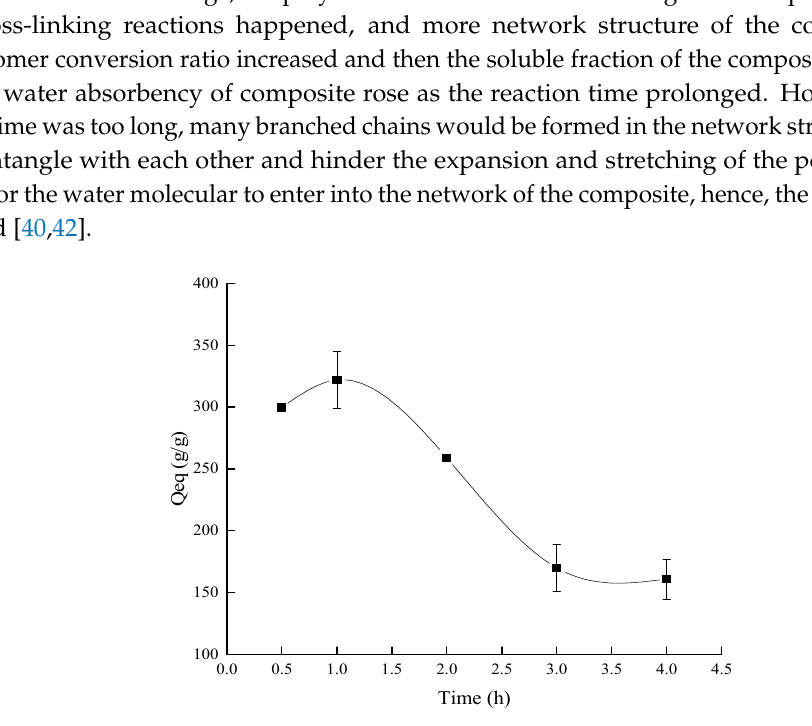
Figure 7. The influence of the reaction time on the water absorbency.